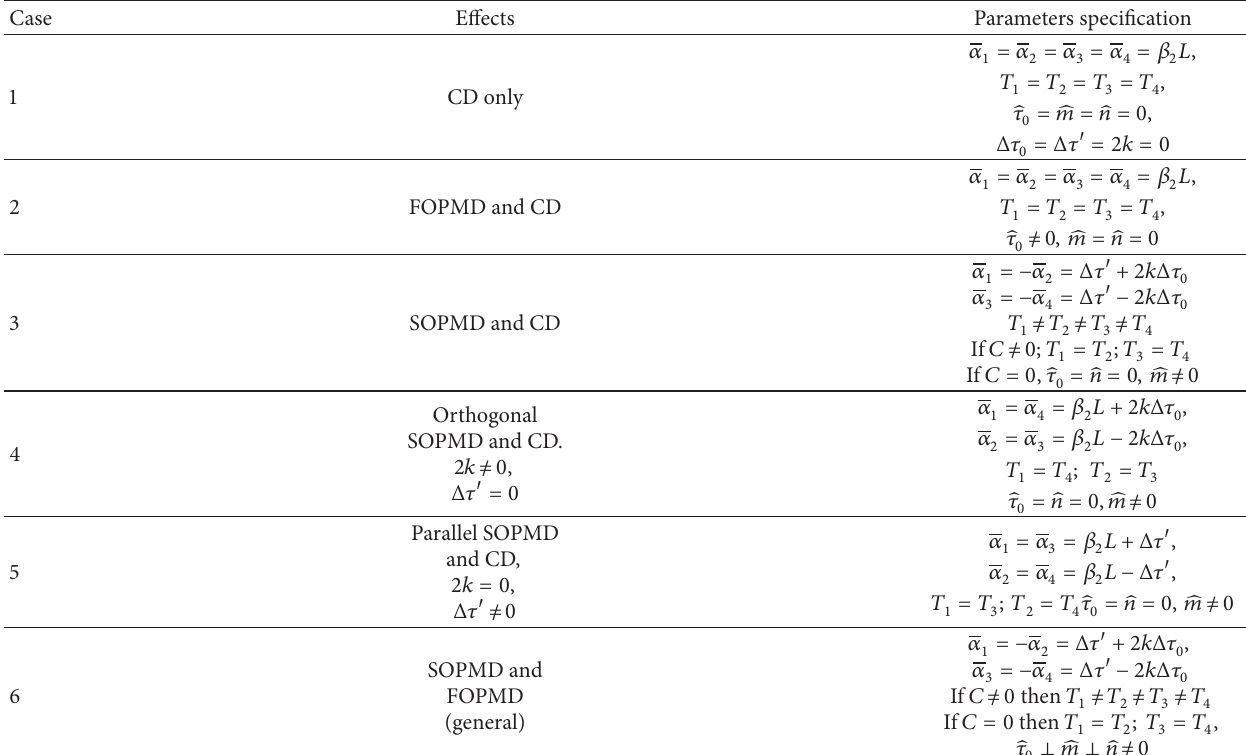
Table 1: Parameters specifications for different